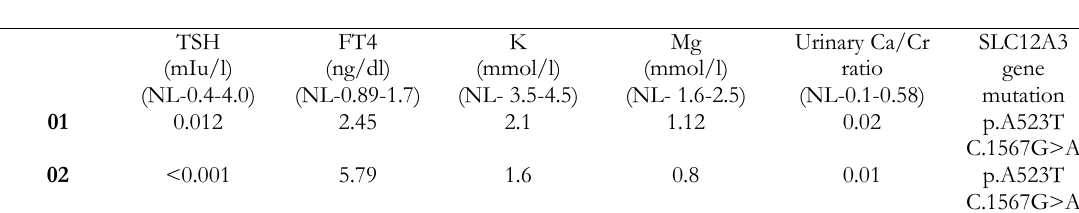
Table 1: Investigations summary of the two